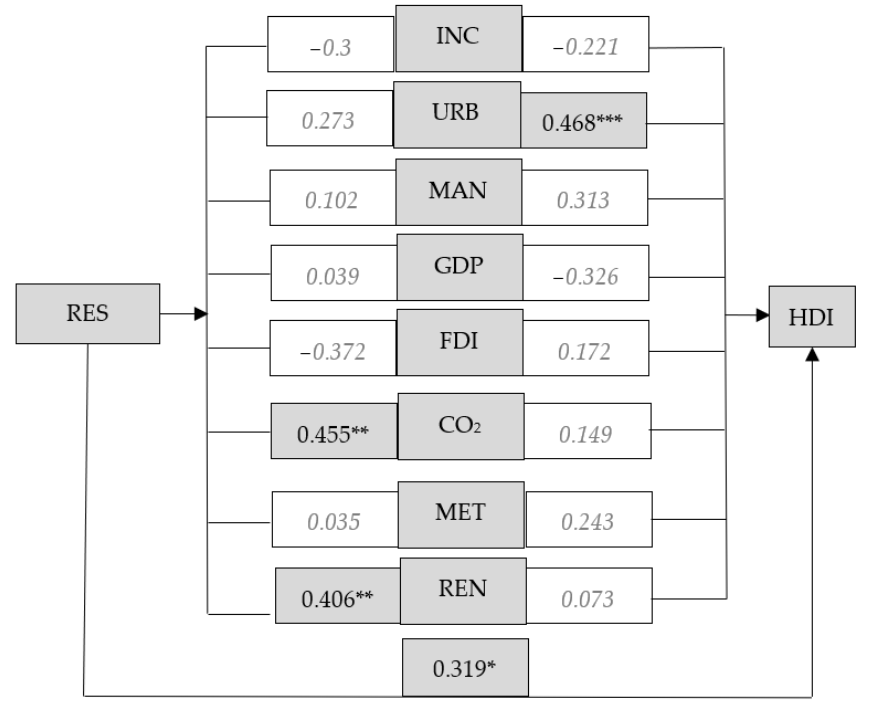
Figure A3. Role of the residential energy use per capita in explaining HDI of EU member states, 2018. Note: the insignificant values are marked with italics and grey. * 10% significance level, ** 5% significance level, and *** 1% significance level.